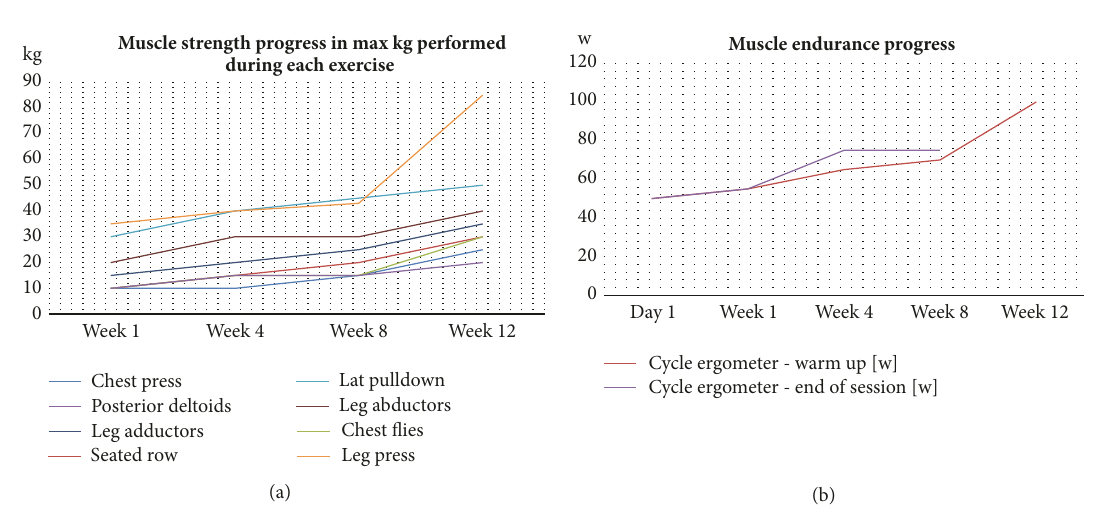
Figure 2: Training progress in patient 2. (a) Muscle strength progress; (b) muscle endurance progress using a stationary bicycle (measured in